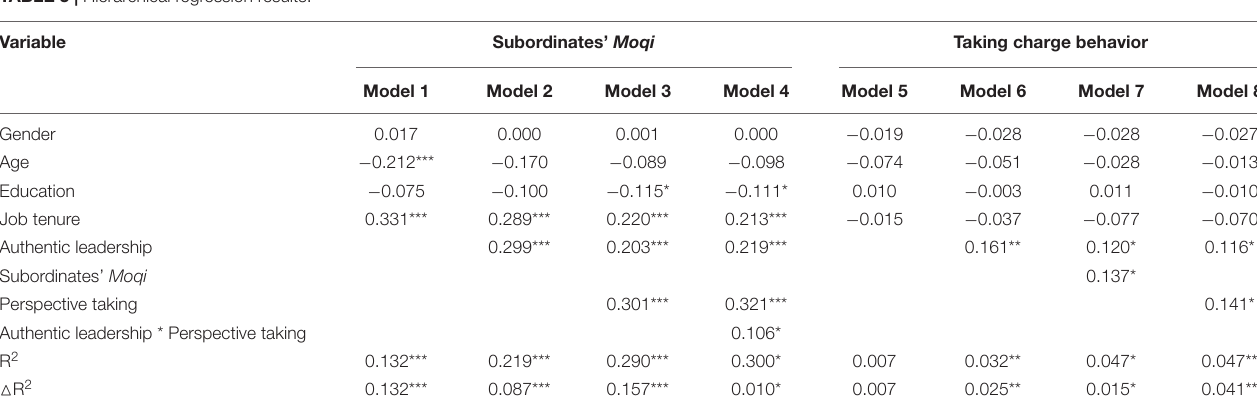
TABLE 3 | Hierarchical regression